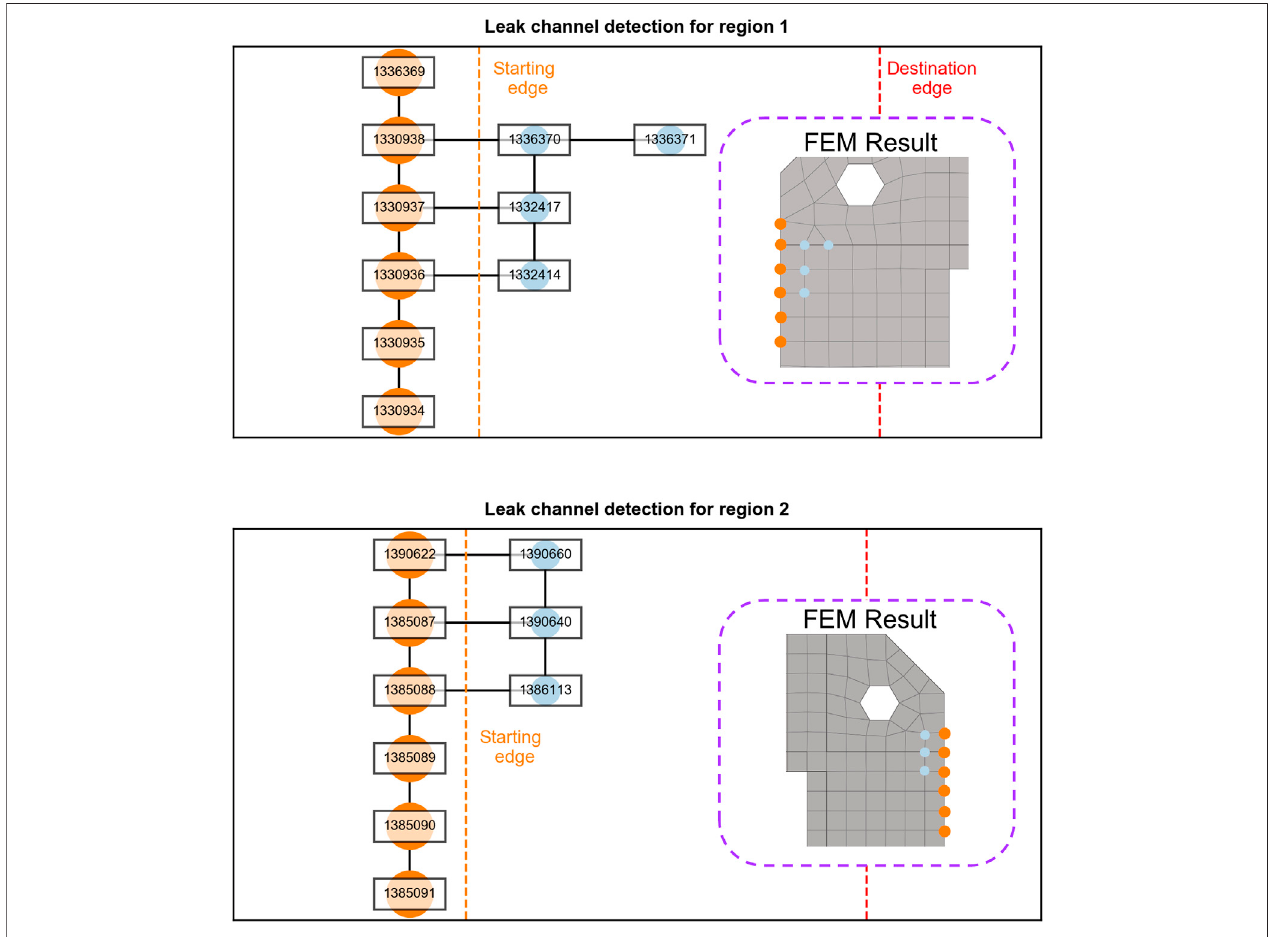
FIGURE 13 | Leak-channel detection for region 1 and 2.